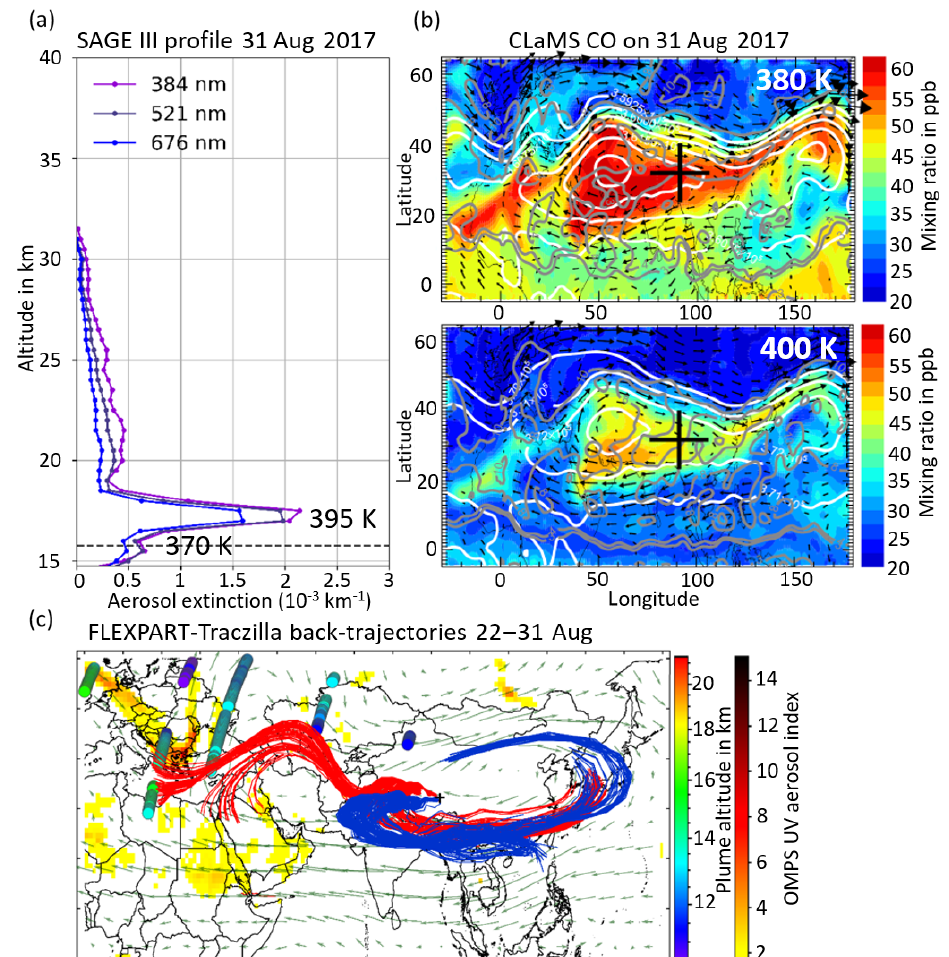
Figure 5. (a) SAGE III aerosol extinction values for the profile taken on 31 August 2017 at 31.53 ◦ N and 91.56 ◦ E. The dotted black line represents the given tropopause height by the SAGE III data set. (b) CLaMS CO map at 380 and 400K on 31 August 2017. Grey lines represent the PV contours at 3.6PVU. The determination of the AMA PV transport barrier works only on a few days in 2017. White lines show the Montgomery stream function. The black cross represents the profile position. (c) OMPS UV aerosol index (yellow-reddish areas) and the plume altitude based on CALIOP observations (blue to green dots), which show enhanced aerosol values due to the fire plume on 22 August (9d prior to the SAGE III measurement profile in a ). Superimposed: every fifth of the 1000 9d back-trajectories calculated using TRACZILLA starting from the respective altitude and position of the two peaks shown in (a) . The blue and red trajectories correspond to the peaks at 15–16km (370K) and 17–18km (395K), respectively, in (a)